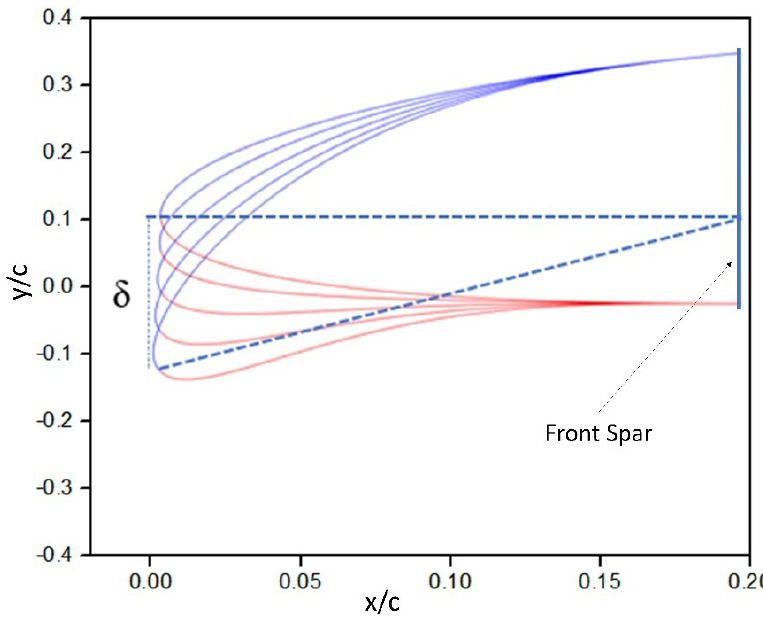
Figure 2. Variable morphing leading edge airfoil at different deflection angles.